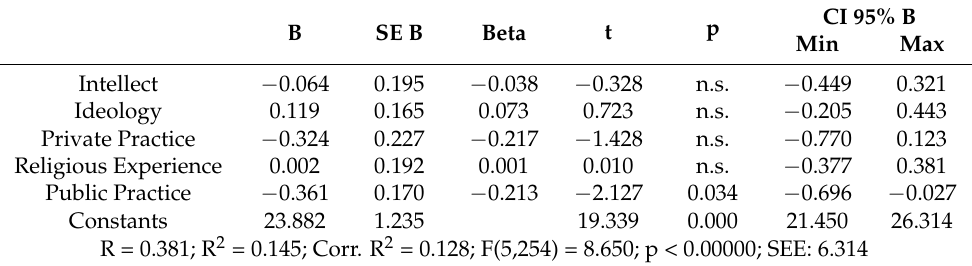
Table 4. Summary of a multiple regression analysis predicting level of COVID-19 fear